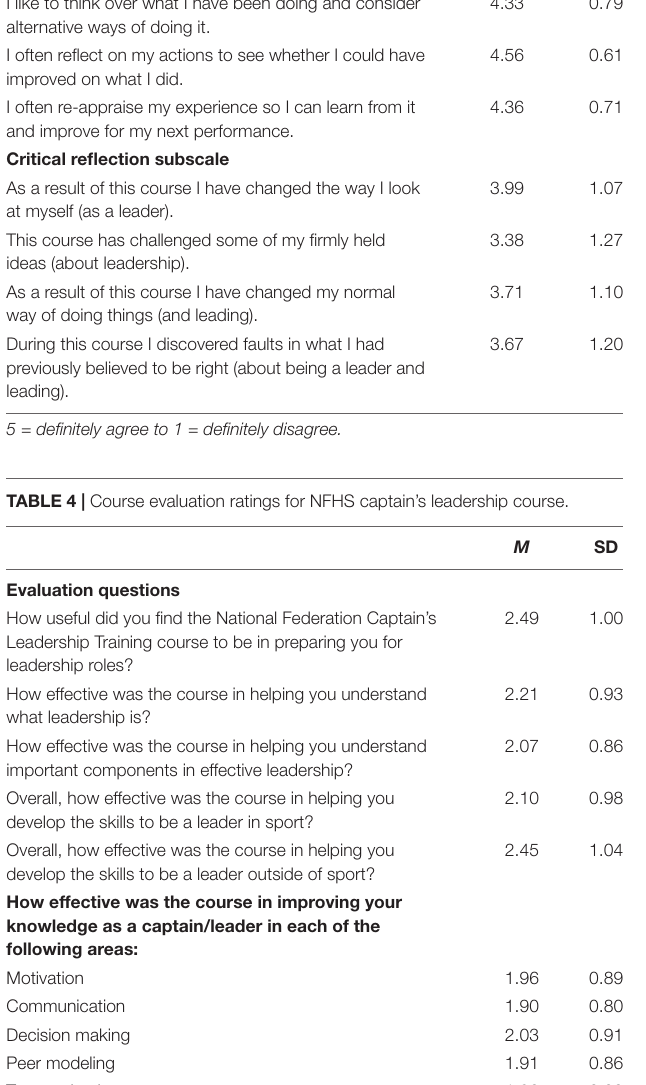
TABLE 3 | Reflective subscale scores.